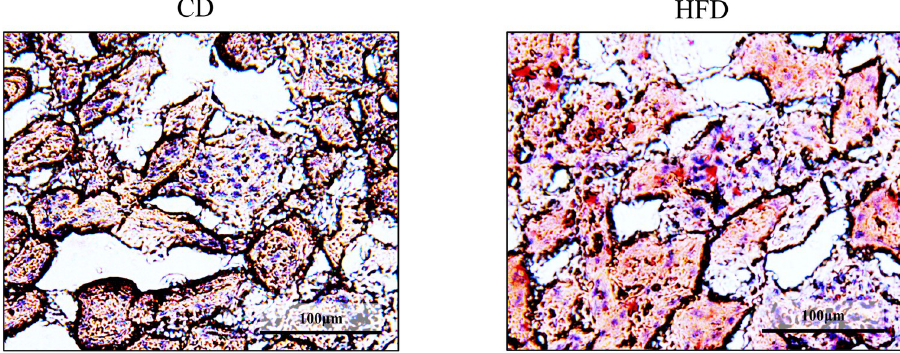
Fig 3. Oil-Red staining of the kidney. Representative images of Oil-Red-stained C57BL6/J mouse renal tissue sections. Lipid depositions are stained in red. Accumulations of neutral lipids are observed in glomeruli and renal tubules in HFD-fed mice. CD, control diet group; HFD, high-fat diet